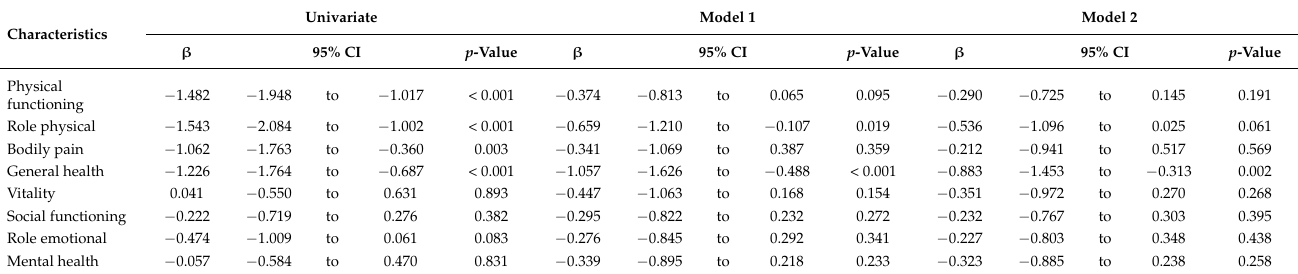
Table 5. Correlation between SF-36 scores and glycoalbumin levels (%).